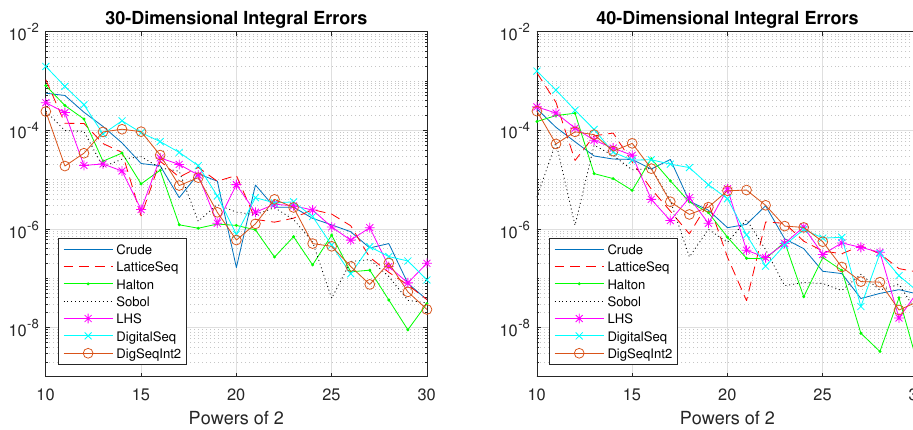
Figure 3. The 30- ( left ) and 40-dimensional ( right ) integral absolute errors. Going to higher dimensions, the best approach for the 50-dimensional integral (Table 5) is again the scrambled Halton sequences with five smallest errors. For the largest values of C , the Digital Sequence produces the best results. It is also noticeable that the former achieves an order of error 1e-9. Table 5. The 50-dimensional integral absolute